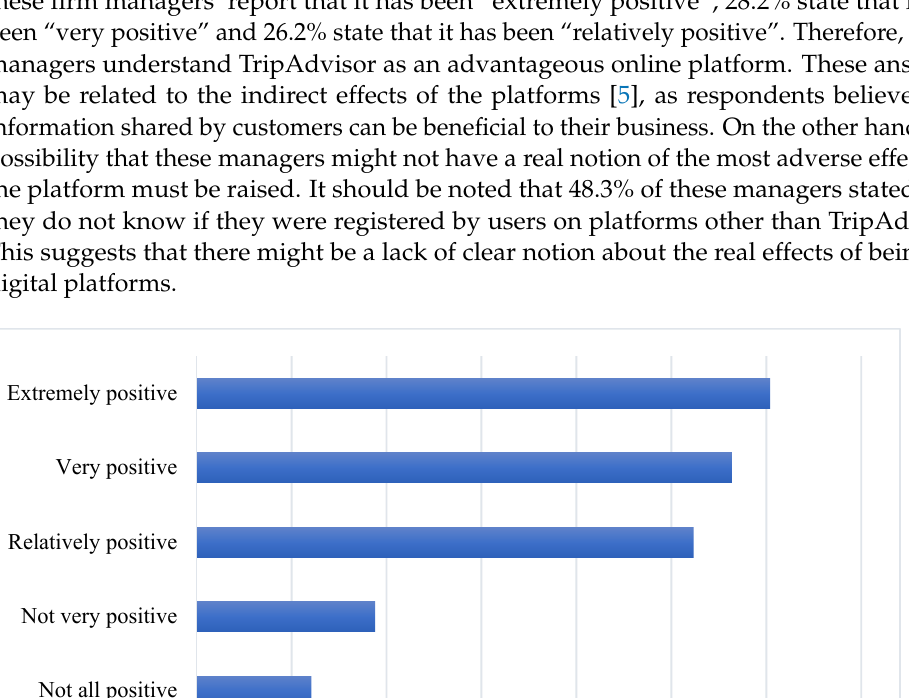
Figure 9. Disadvantages of registration in TripAdvisor (%).